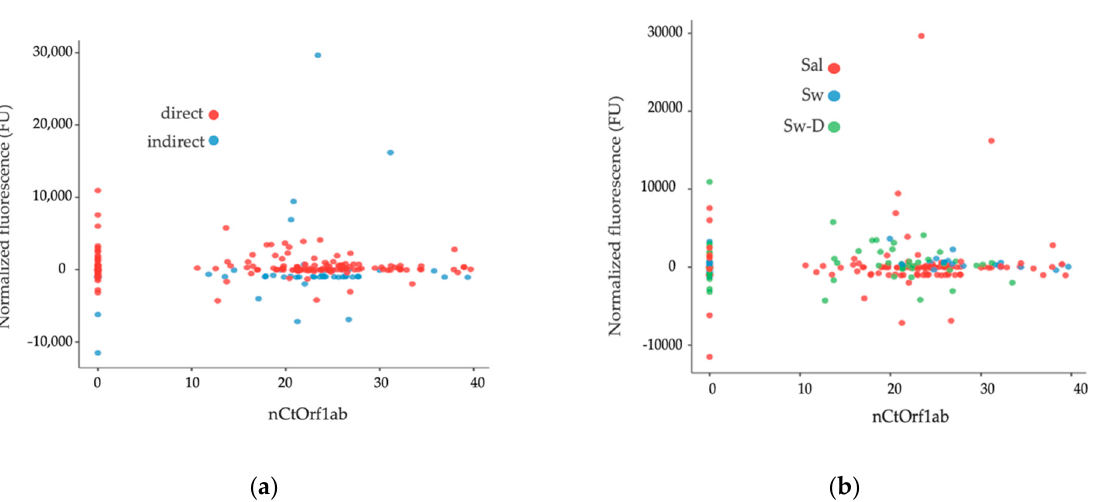
Figure 2. Distribution of fluorescence readings in tested samples. ( a ) Scatter ‐ plot colored for direct and indirect protocols; ( b ) Scatter ‐ plot colored by sample type.